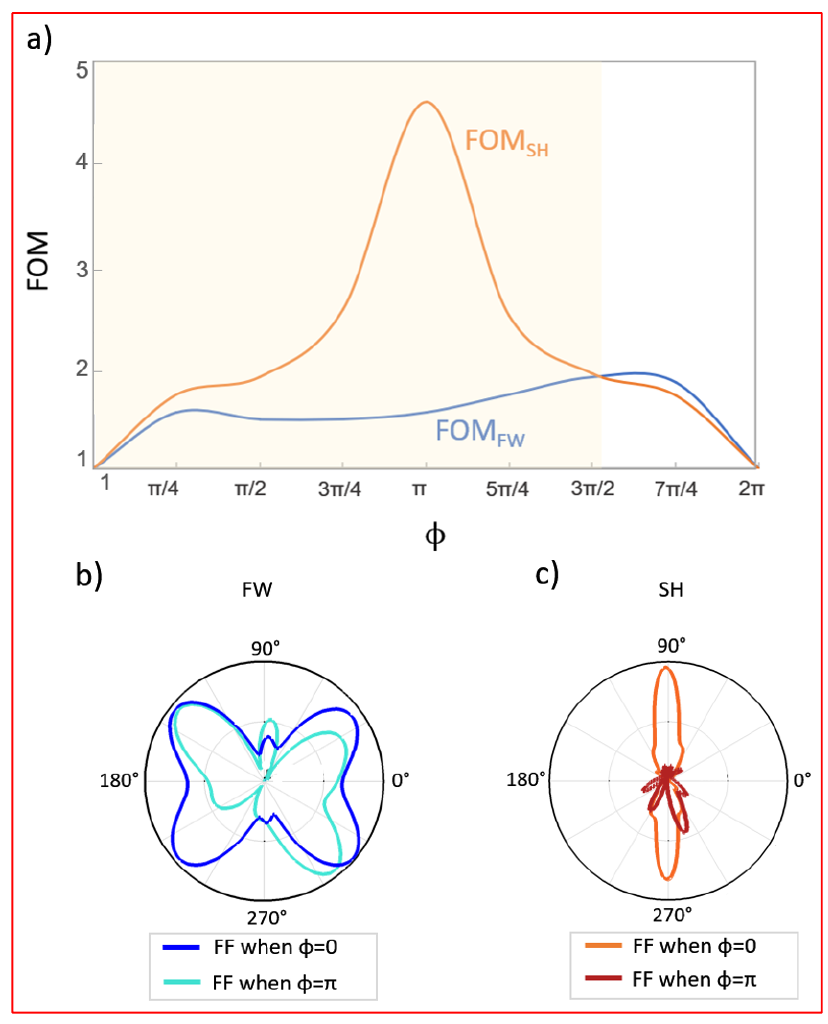
Figure 5. ( a ) The figure of merit (FOM) of the far field at the fundamental and second harmonic, respectively. The fundamental ( b ) and second harmonic ( c ) far field modification in the presence of the perturbation assuming as the reference cases ϕ is equal to 0 and π.